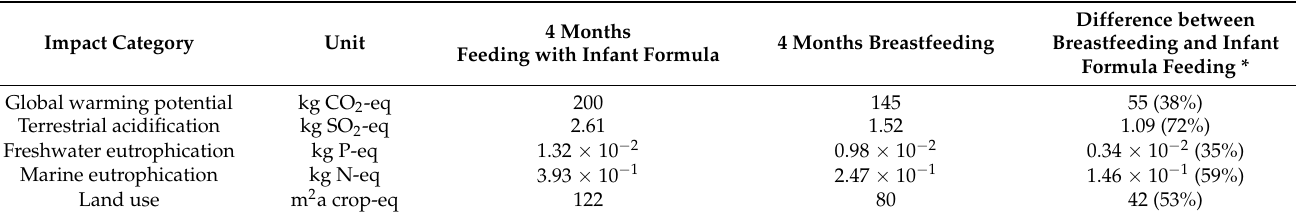
Table 4. Environmental impact from four months exclusive feeding with infant formula and four months exclusive breastfeeding, and the difference between the